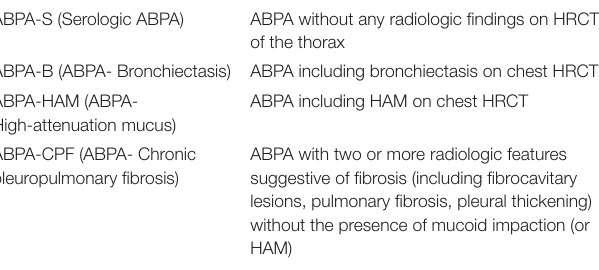
TABLE 5 | Radiologic classification of ABPA based on clinical and HRCT findings.